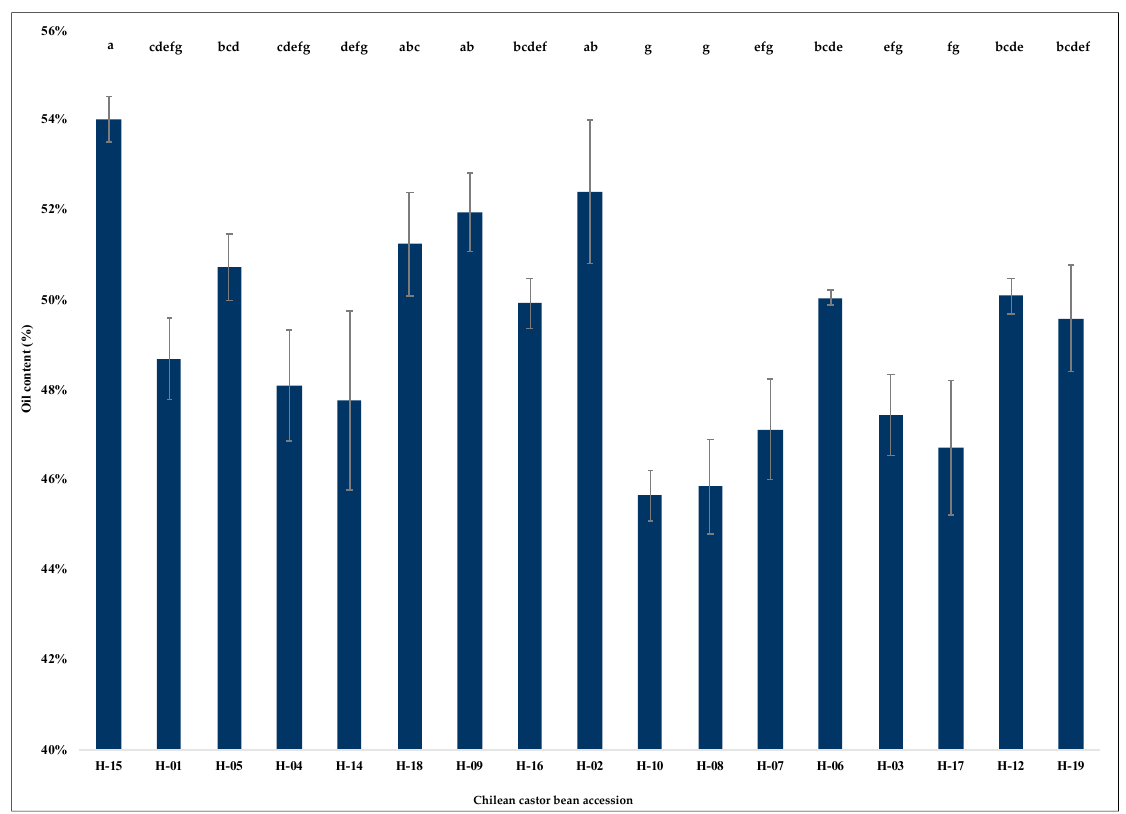
Figure 1. Castor bean seed-oil content in different Chilean accessions. Oil content (%) corresponds to the mean for three replicates. Vertical bars represent standard error of the mean (n = 3), and different lowercase letters in the columns represent statistically significant differences ( p < 0.05).